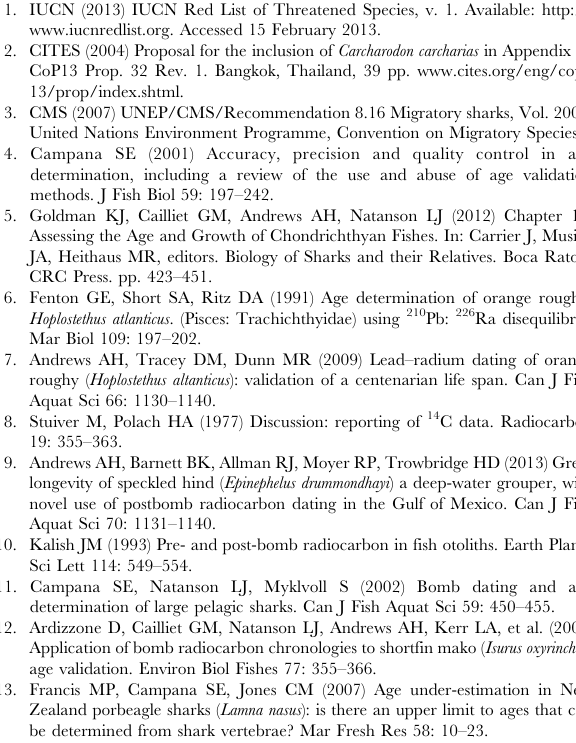
Table S2 Calculating the summed squared differences for optimal chronology shifting. The top line for each chronology is its original placement based on band pair counts. Subsequent lines move the D 14 C values step-wise one year closer to their corresponding date on the reference chronology (the values in column 3 from Table S1). Columns ‘‘Diffs. 1–4 0 refer to the squared differences between the date on the reference chronology and the step-wise adjusted year. ‘‘Sum’’ is the summed squared differences for all points from one shark, and the optimum shift is when this value is minimized; these values have been bolded and starred (*) for each chronology. Table S3 D 14 C and d 13 C ( % ) shark sample data listed by